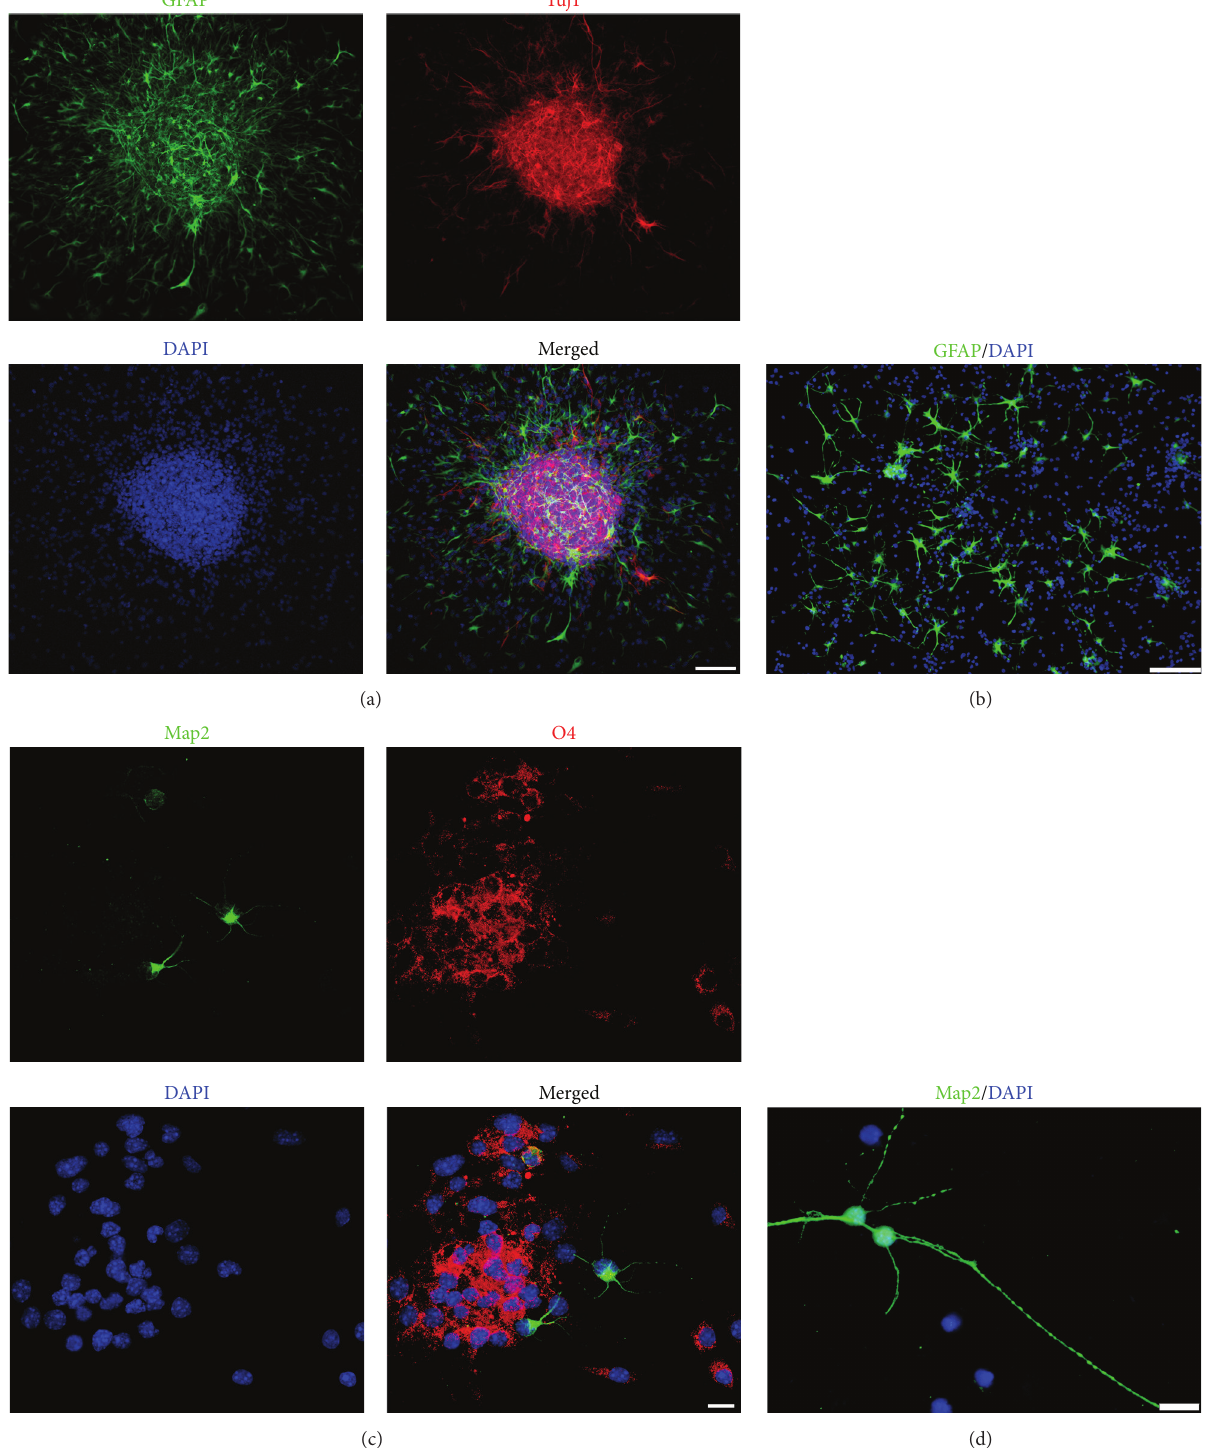
Figure 2: Differentiation of SMINS-TTF-3 cells in vitro . (a-b) SMINS-TTF-3 cells spontaneously differentiated into astrocytes marked by GFAP (green) and neurons marked by Tuj1 (red) in spontaneous medium for one week. (c-d) SMINS-TTF-3 cells spontaneously differentiate into neurons marked by Map2 (green) and oligodendrocytes marked by O4 (red) in spontaneous medium for three weeks. DAPI was used for nuclei counterstaining (blue). Scale bar: 100 𝜇 m (a and b) and 10 𝜇 m (c and